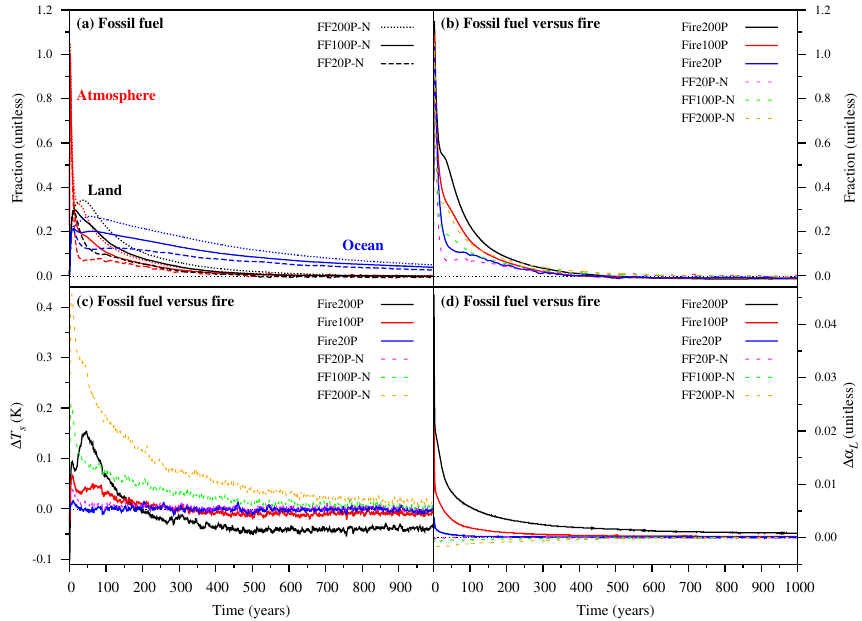
Figure 5. Effect of fossil fuel emissions set equal to net fire emissions. (a) Changes in global carbon stocks, expressed as fractions of each fire pulse magnitude. (b) Comparison with fire for the total atmospheric carbon, expressed as a fraction of each fire pulse magnitude. (c) Comparison with fire for the global mean atmospheric surface temperature. (d) Comparison with fire for the global mean land surface albedo.